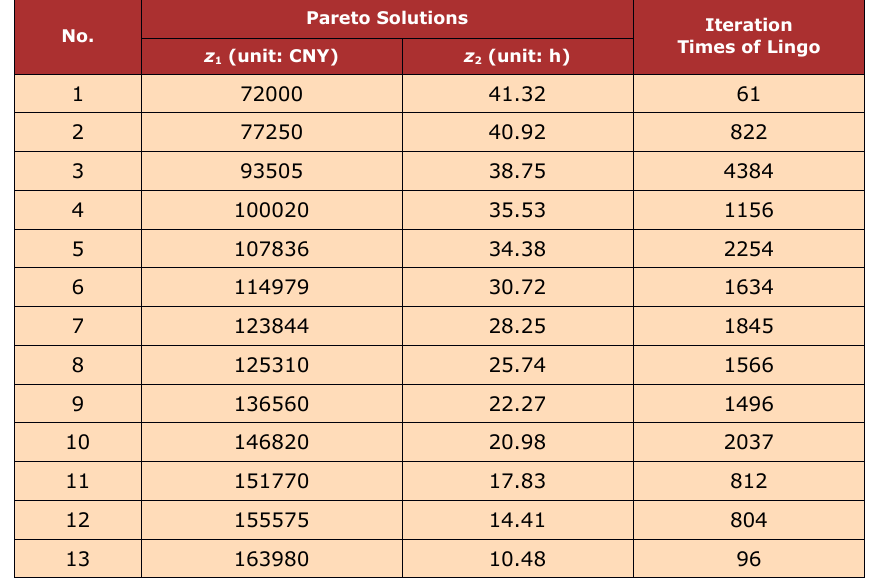
Table 6. Calculation results of Lingo